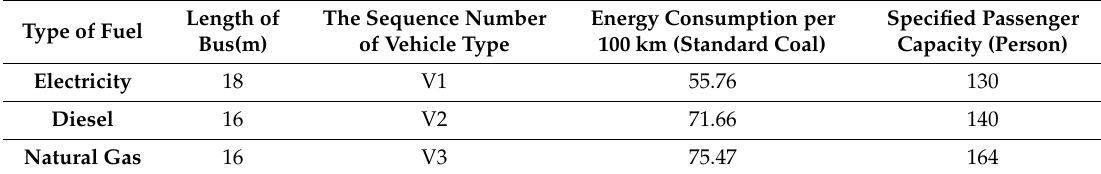
Table 2. Vehicle information.